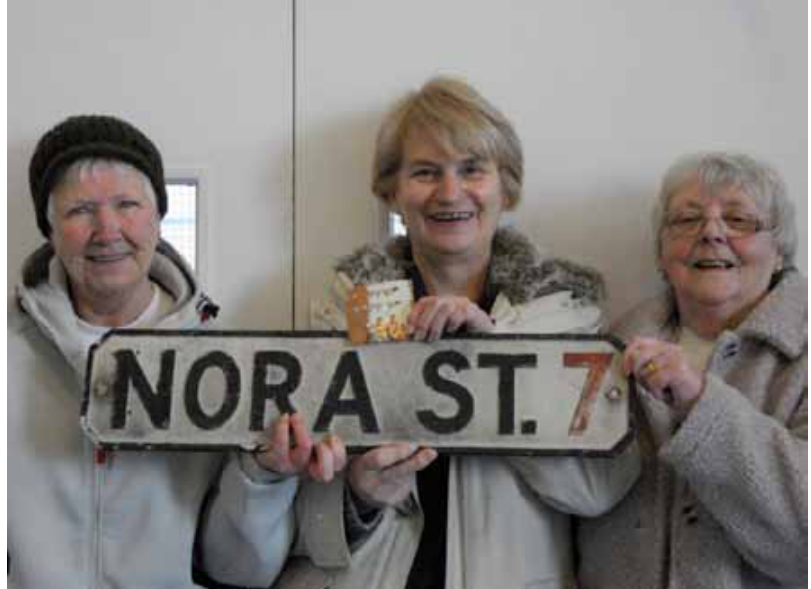
Figure 7: Nora Street resident Elsie Winstanley (left), with the sign that she kept for 38 years. Friends Dorothy Criechton (centre) and Maureen Murphy (right)